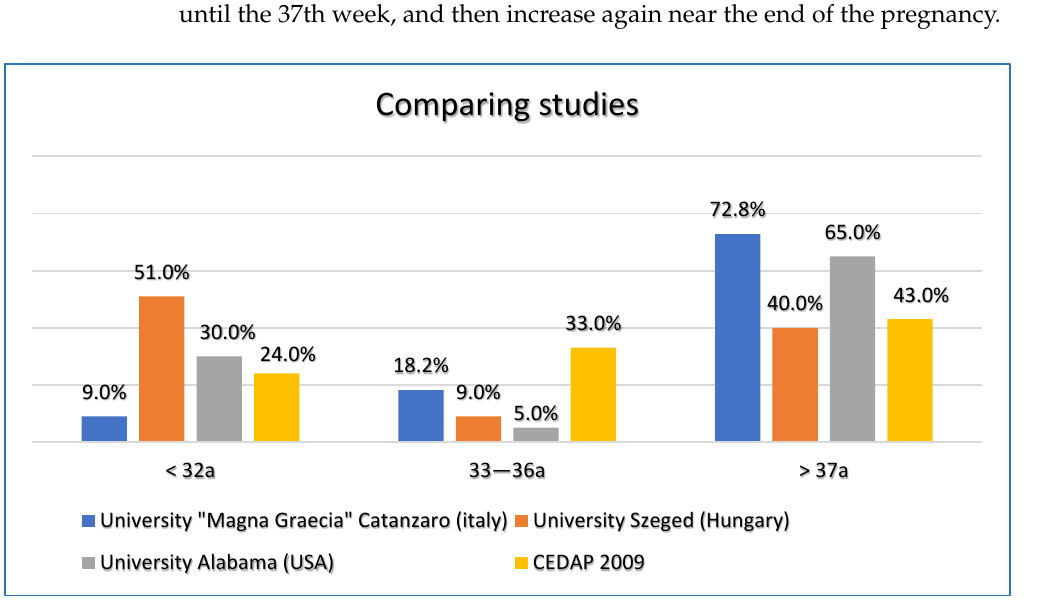
Figure 5. Comparing studies.